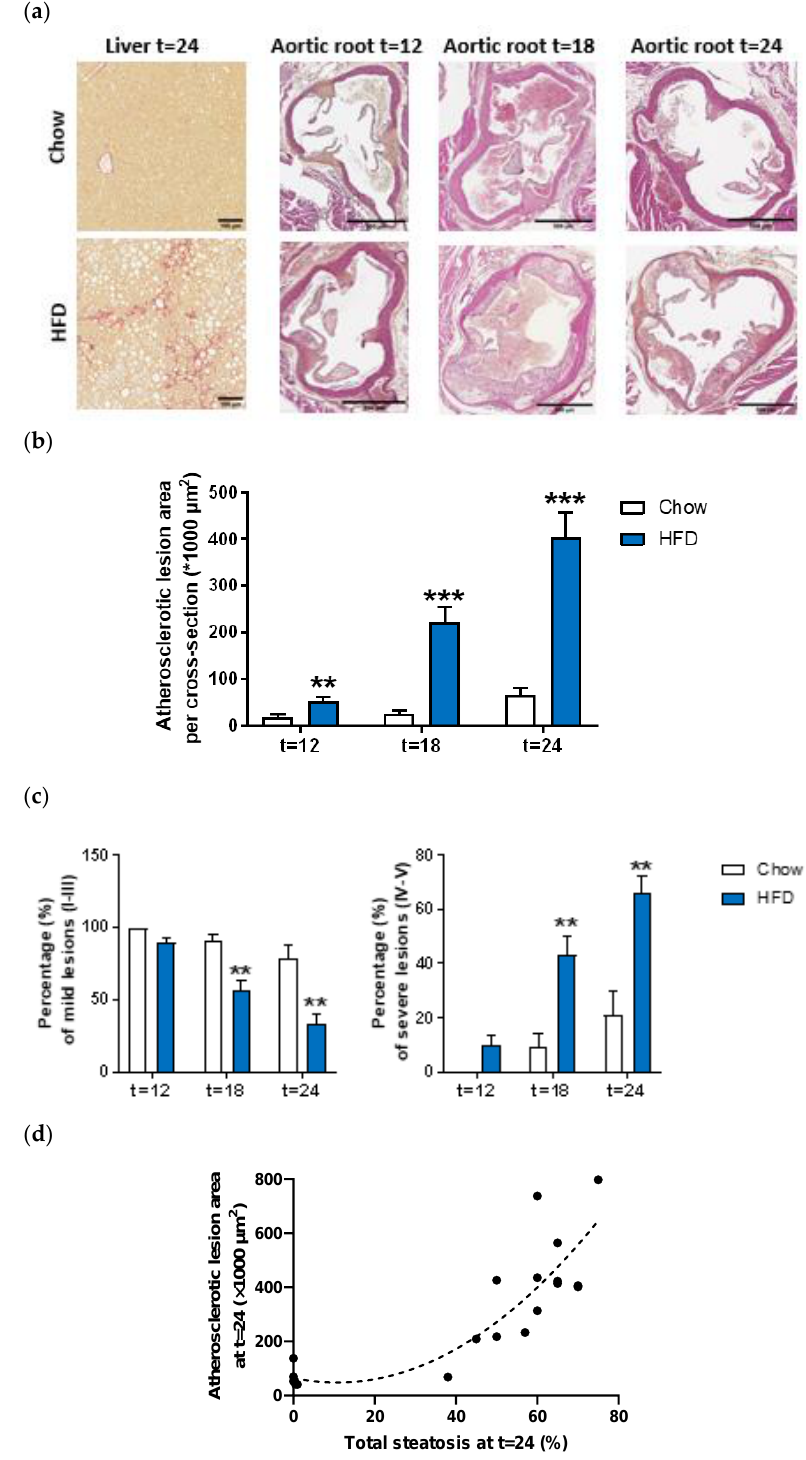
Figure 1. Representative images of liver cross-sections stained with Sirius red or aortic root section stained with haematoxylin-phloxine-saffron (HPS) ( a ) of Ldlr − / − .Leiden mice fed a low-fat chow diet or fed a high-fat diet (HFD) for 12, 18 or 24 weeks. Total lesion area per cross-section was quantified ( b ) and lesion severity was assessed, categorized as mild lesions (type I-III) and severe lesions (IV-V) ( c ). Furthermore, quadratic correlation of atherosclerotic lesion area with hepatic steatosis was calculated ( d ). Values represent mean ± SEM for n = 6 chow and n = 15 HFD mice/time- point. ** p < 0.01, *** p < 0.001 vs.